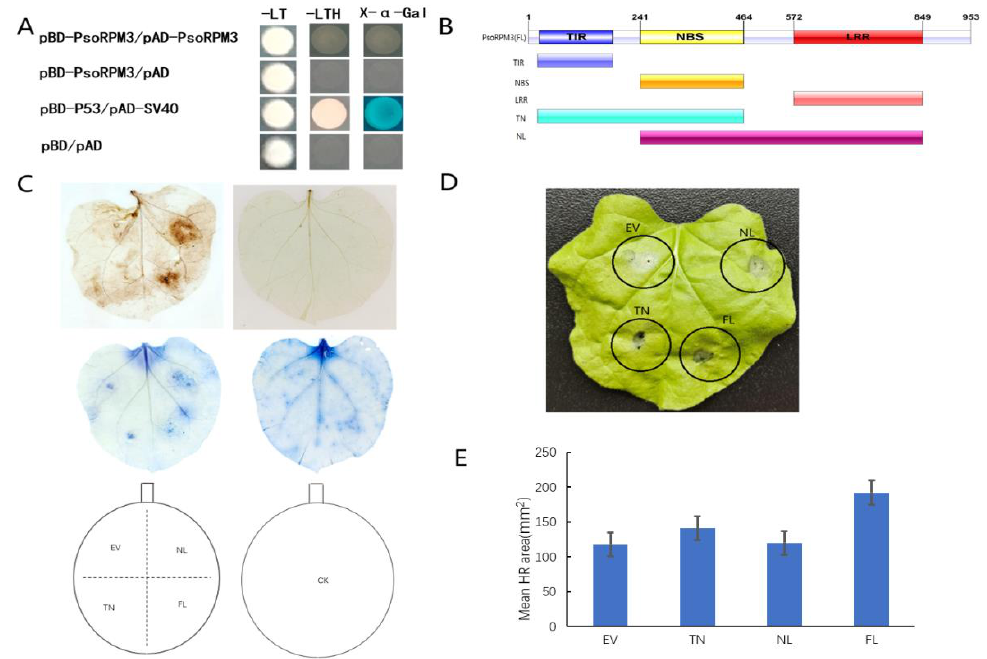
Figure 2. ROS (Reactive oxygen species) burst detection and cell death staining in the PsoRPM3 disease resistance response. ( A ) Analysis of interactions between PsoRPM3 and PsoRPM3 using the yeast two-hybrid system. α-Galactosidase activity was detected using X-α-Gal as a substrate. ( B ) Segmentation pattern of the structural domain of PsoRPM3 protein. ( C ) The brown color is DAB for reactive oxygen species staining in HR reaction, and the blue color is trypan blue for cell necrosis staining. ( D ) HR responses observed in tobacco ( N. benthamiana) leaves transiently overexpressing empty vector, TN, NL, and FL 1 d after inoculation with M. incognita . ( E ) Determination of cell ne- crosis area to ( D ). 2.3. Interaction of PsoRPM3 Protein with Downstream Transcription Factor Pso9TF The above studies have shown that PsoRPM3 protein could activate the production of ROS and induce HR responses, for which the components downstream of the disease resistance signal were not clear. We screened a number of complexes bound to PsoRPM3 protein in Xinjiang wild myrobalan plum ( P. sogdiana ) by CO-IP based on its localization in the nucleus, including a transcription factor Pso9TF . We cloned the Pso9TF gene from P. sogdiana . The phylogenetic tree analysis revealed that Pso9TF was a basic leucine zipper transcription factor or kinase (Figure 3A), and its protein structure contained the PB1 structural domain (Figure 3B). The subcellular localization result showed that Pso9TF was localized in the nucleus (Figure 3C). The transcriptional self-activation assay revealed found Pso9TF has transcriptional self-activation activity (Figure 3D). Further, yeast two- hybrid assays showed that there was an interaction between Pso9TF and the full-length (FL) and LRR structural domains of the PsoRPM3 protein, but not with the TIR, NBS, TN and NL structural domains (Figure 3E). Their relationships were also verified by BiFC assays (Figure3F).